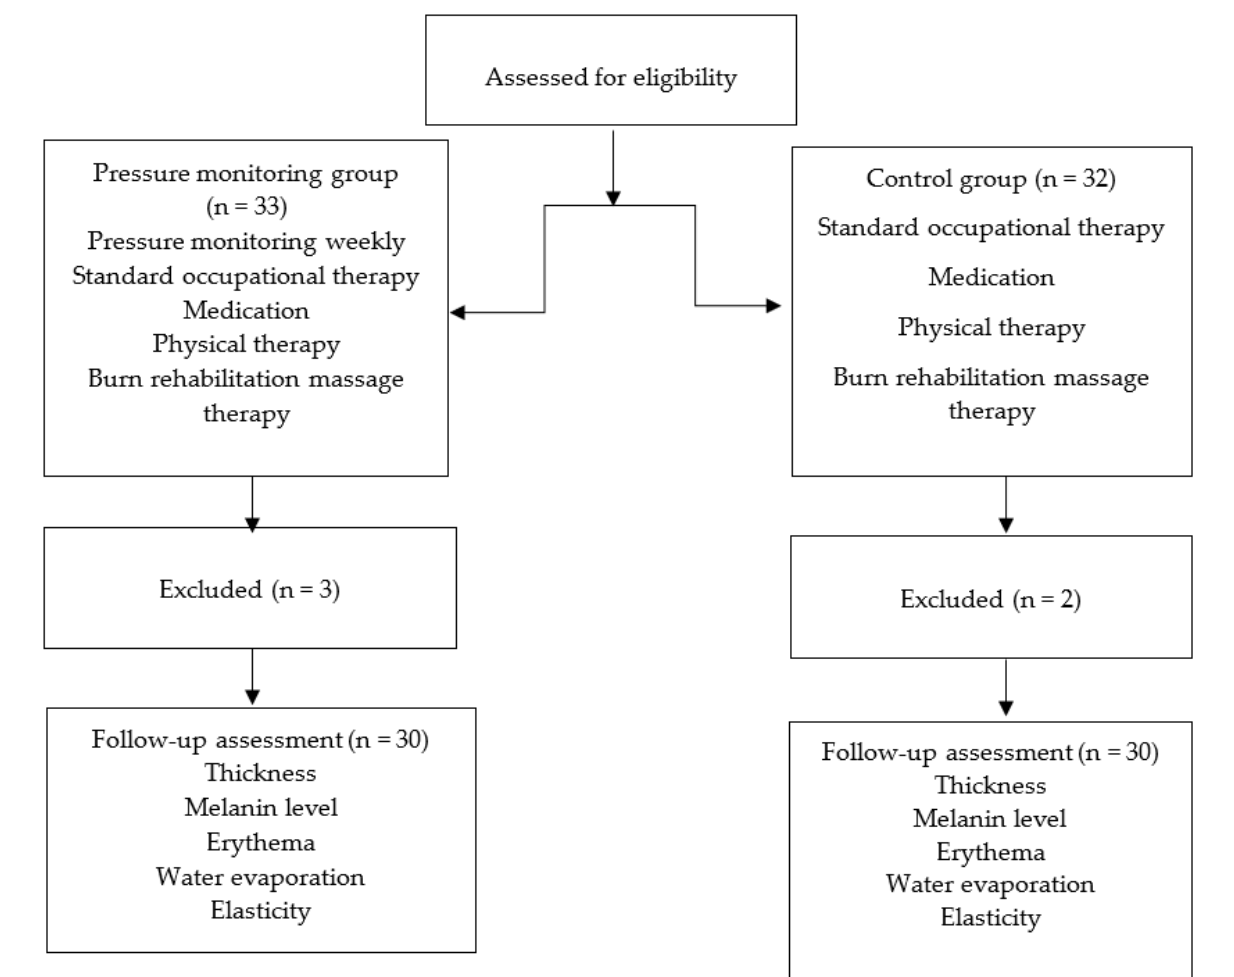
Figure 1. Schematic for subject enrollment, allocation, and follow up.